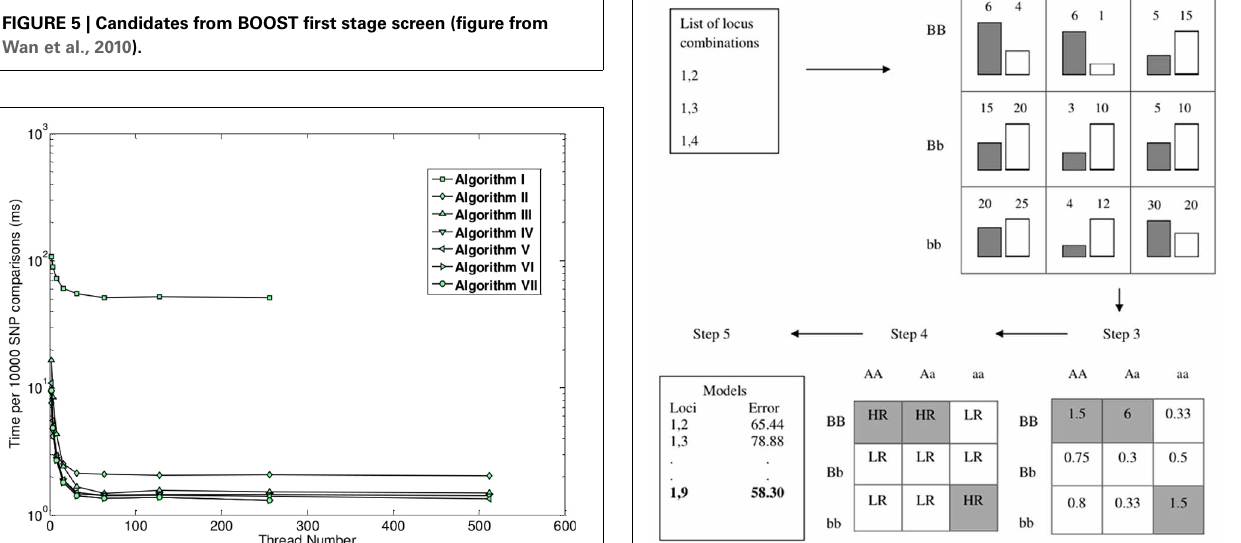
FIGURE 6 | Runtime as a function of number of active threads across different optimization levels (figure from Yung et al., 2011).